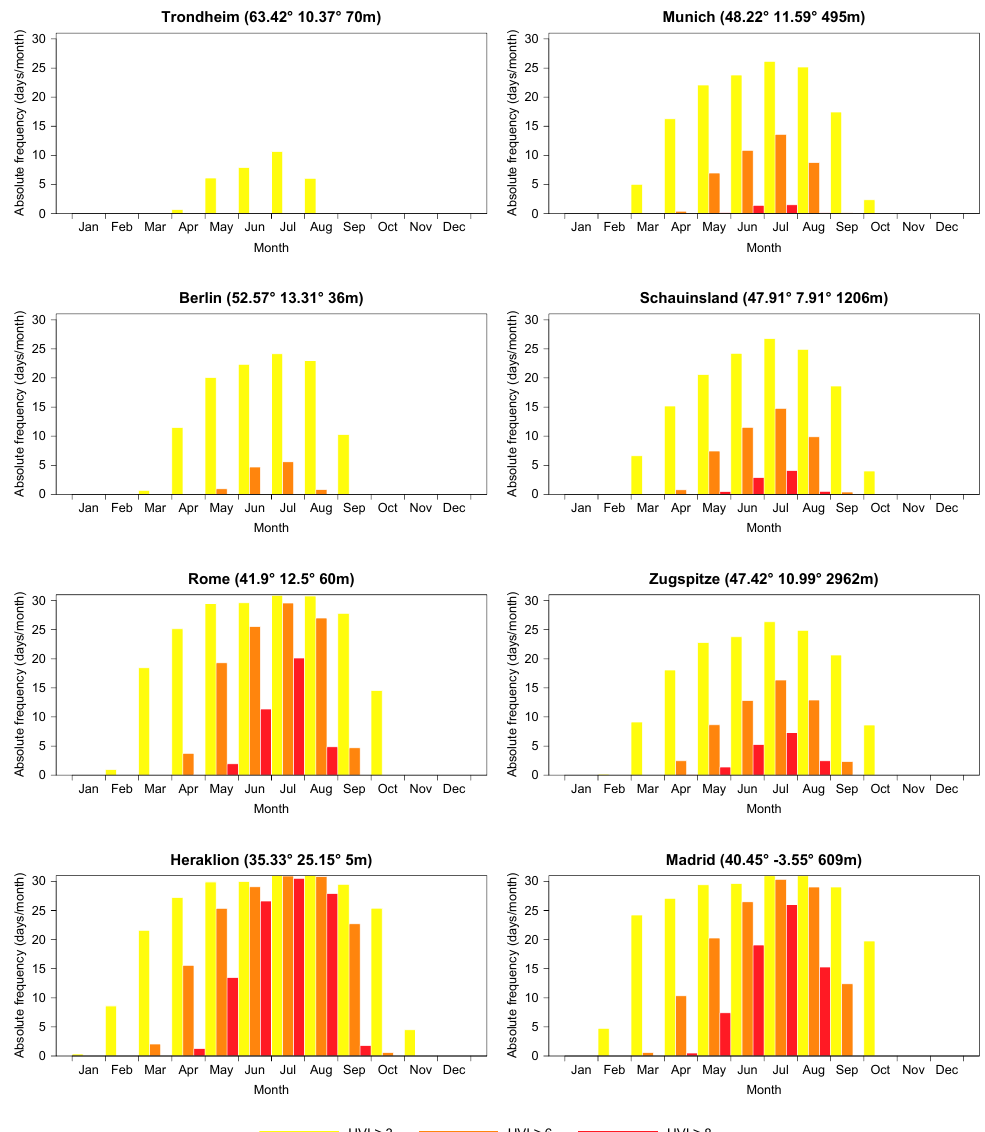
Figure 8. Satellite-based absolute number of days per month reaching the noontime UVI all − sky classes “moderate” (UVI ≥ 3), “high” (UVI ≥ 6), and “very high” (UVI ≥ 8). Even 38 days and 102 days per year are detected with very high UVI, respectively. Moderate UVI values are detected between February and October at averaged 41%, 39% and 41% over this period with maximum frequency values per decade of 76%, 69% and 82% in Munich, Schauinsland and Zugspitze. At all three locations, high UVI values occur from the second decade of April until end of September with about 25% of the days. In Munich, very high UVI values are detected between the third decade of May until the second decade of August at averaged 10% of the days and a maximum probability of 22% during the first decade of July. At Schauinsland, the occurrence of very high UVI values is extended from the second decade of May until the third decade of August, when 14% of the days have UVI ≥ 8 during this period. There is a probability of up to 42% of very high UVI in the first decade of July at Zugspitze and even 19% of the days between the third decade of April and the first decade of September reach very high UVI values. Throughout the year, there are 41 days of high UVI in Munich, 45 days at Schauinsland and 56 days at Zugspitze. Also, days with very high UVI increase with the altitude, as Munich only has 3 days, Schauinsland has 8 days and even 17 days of UVI ≥ 8